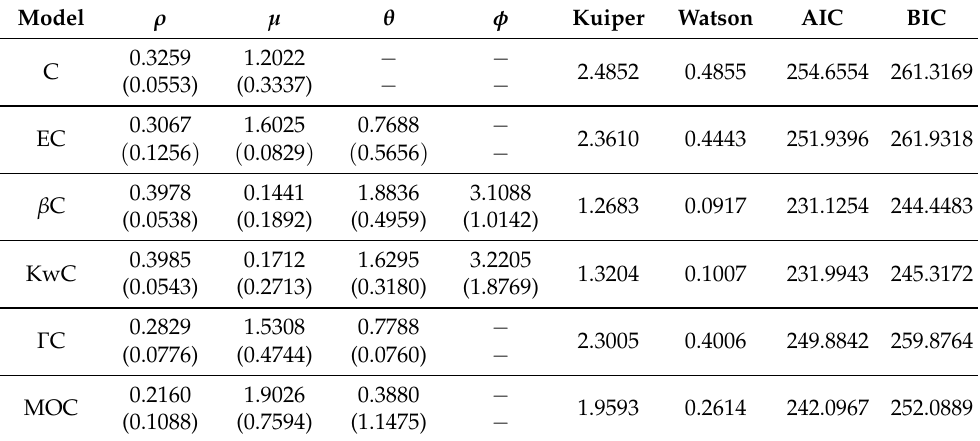
Table 4. MLEs of the parameters for the second dataset, their standard errors (given in parentheses), and the Kuiper, Watson, AIC, and BIC